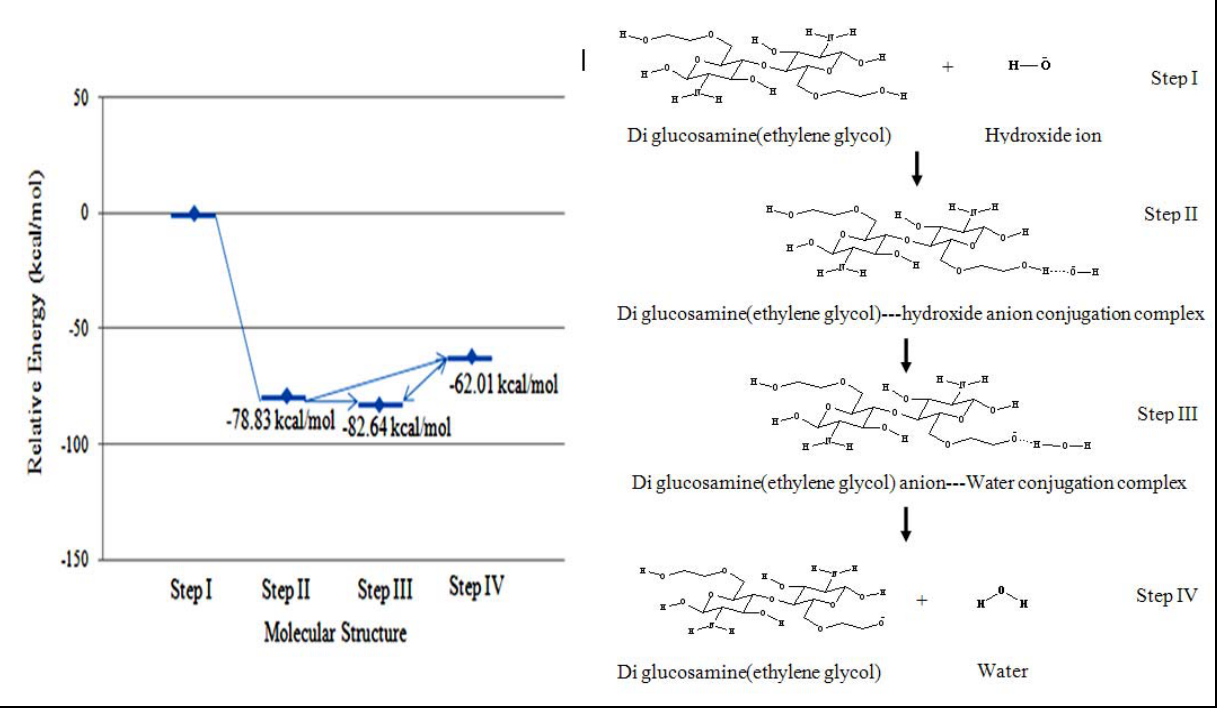
Figure 6. Relative energies of reaction intermediates during the deprotonation of diglucosamine(ethylene glycol) calculated with B3LYP/6-31G//PM3. The reaction mechanism involves the four steps listed below.